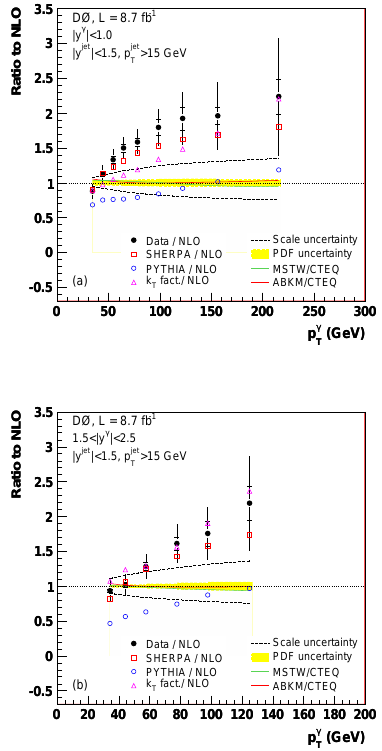
Figure 2. The ratio of γ + b -jet di ff erential cross sections between data and NLO predictions with uncertainties for the rapidity re- y γ < 1 . 0 (Upper) and 1 . 5 < y γ < 2 . 5 (Lower). The gions | | | | uncertainties on the data include both statistical (inner error bar) and full uncertainties (entire error y jet < 1.2 same- | |